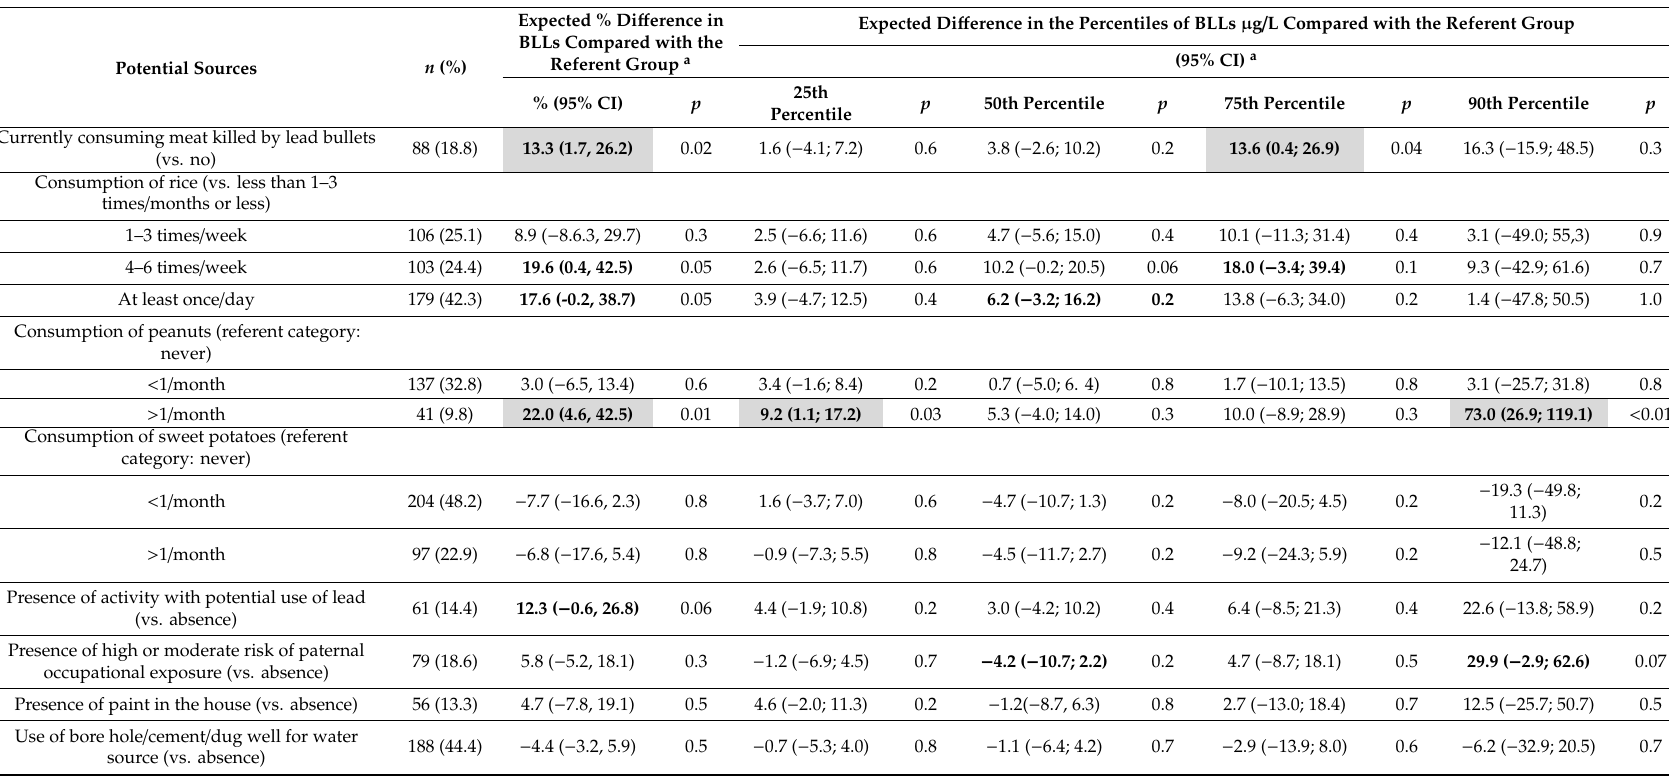
Table 3. Multivariable analyses identifying potential sources of lead at di ff erent percentiles of BLLs in 6-year-old children in Benin, 2016–2018 ( n = 390). Potential Sources n (%)